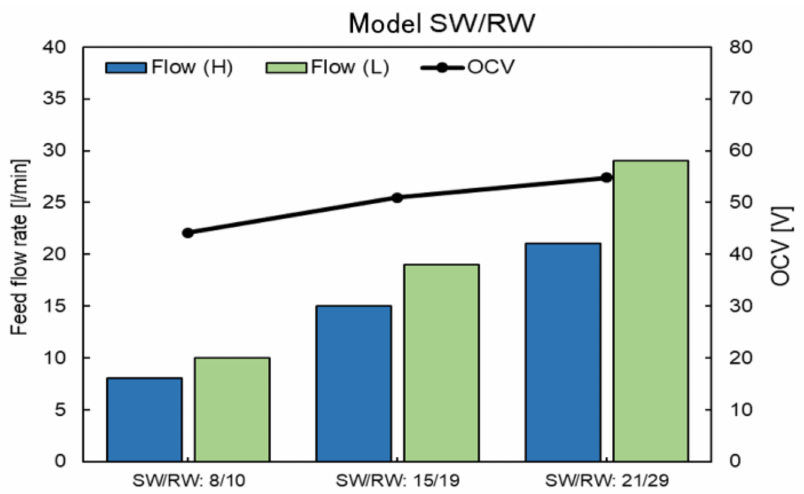
Figure A8. OCVs of RED stack using model SW and RW feed solutions at different feed flow